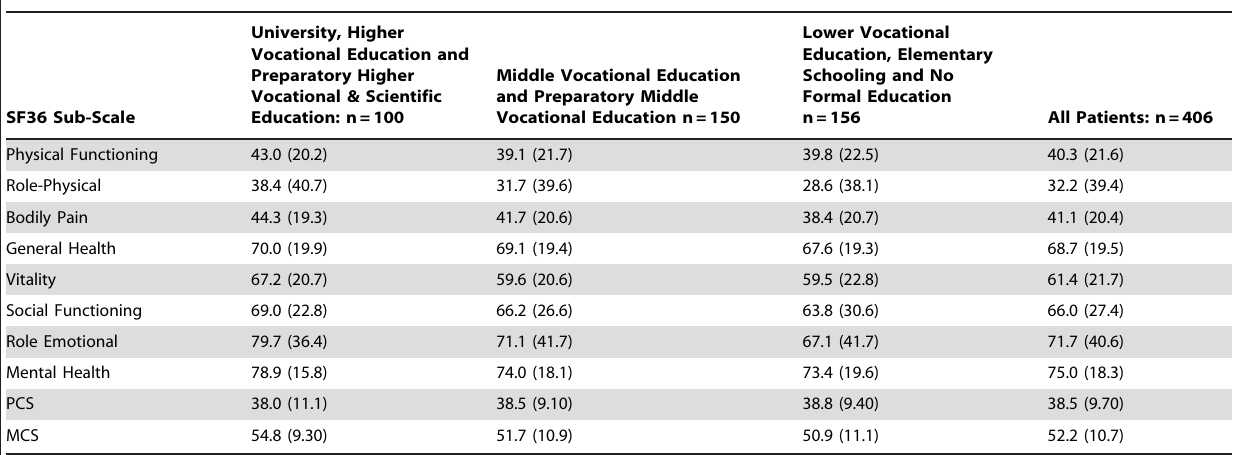
Table 2. Quality of Life before Hip Replacement: A Comparison Between Patients with different Completed Levels of